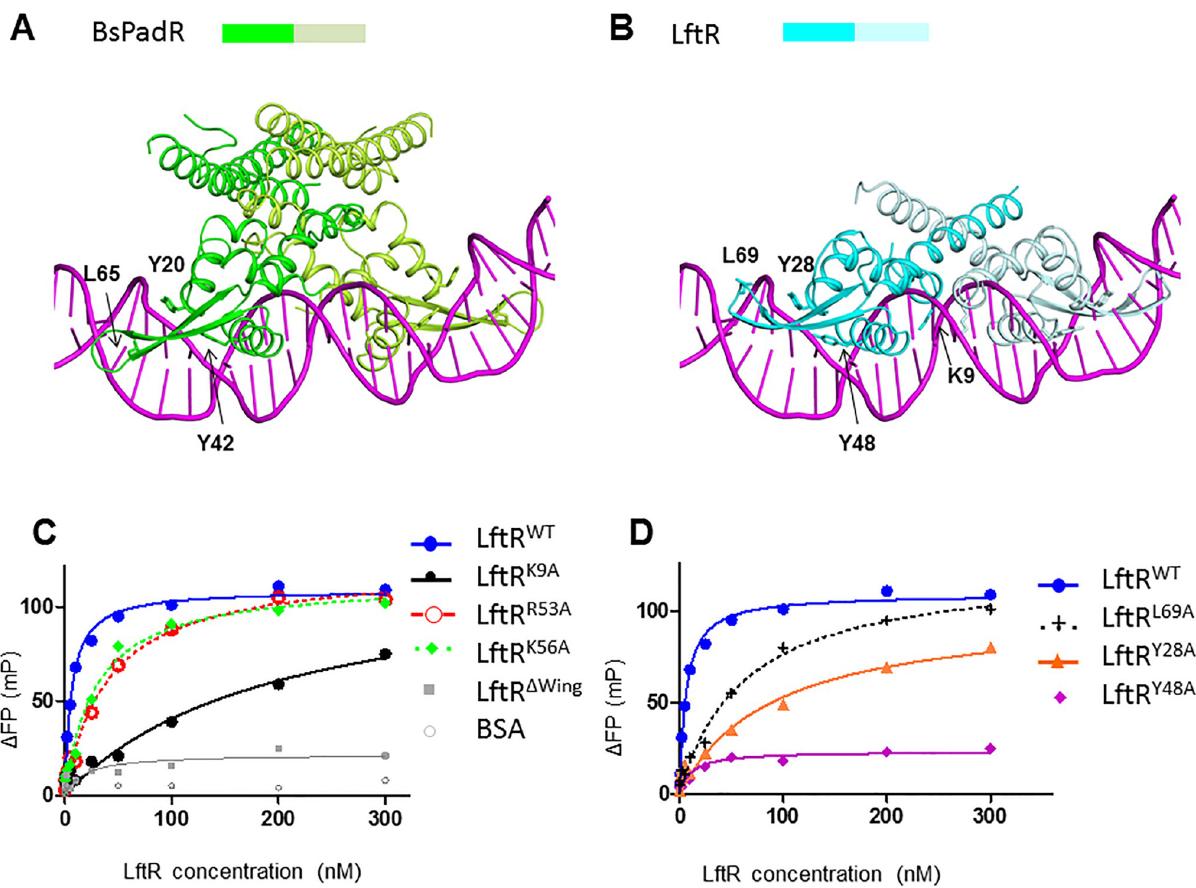
Fig 4. DNA recognition mode of LftR in comparison with BsPadR. (A) Structure of a complex between BsPadR (green and light green) and its operator DNA (magenta). The Y20, Y42, and L65 residues of BsPadR were shown to be critical in DNA binding and are represented by sticks with labels in the figure. (B) Homology-based structural model of the LftR-DNA complex (LftR, cyan and light cyan; DNA, magenta). The LftR Y28, Y48, and L69 residues that correspond to BsPadR Y20, Y42, and L65, respectively, are shown as sticks with labels. The LftR-specific DNA-binding residue K9 is also depicted with sticks. (C, D) Fluorescent polarization (FP) analysis for the interactions of wildtype and mutant LftR proteins with 28-mer OP-1 dsDNA.